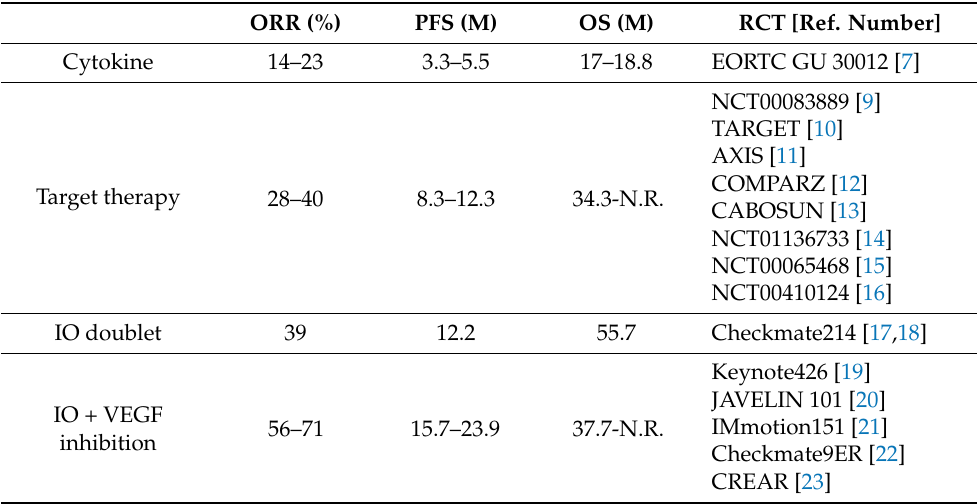
Table 1. Summary of efficacy in patients with ccRCC.